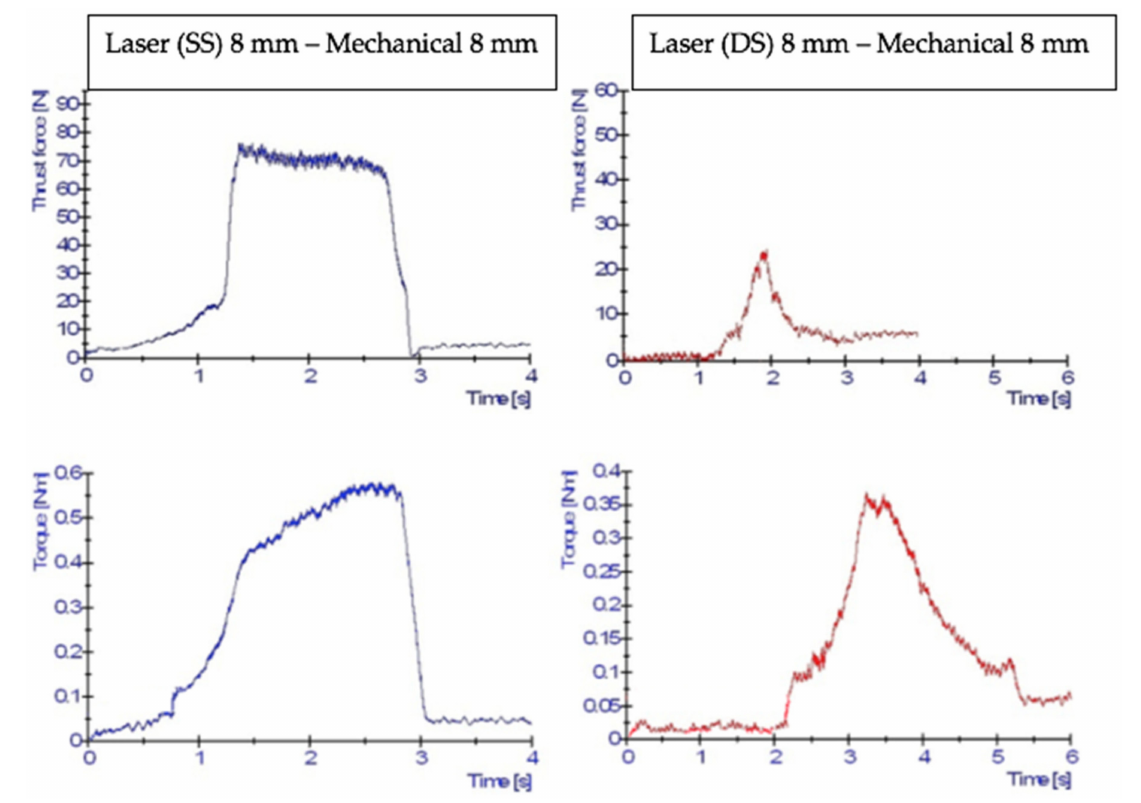
Figure 7. Typical examples of thrust force and torque signal diagrams for uncoated tungsten carbide